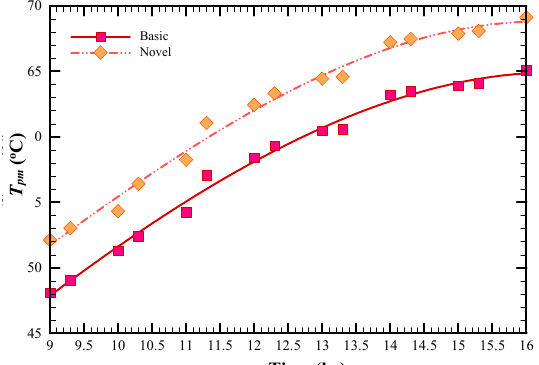
Figure 7. Variation of heat loss for the basic system without a turbulator and novel PTSC equipped with a turbulator and filled with nanofluid at ϕ = 0.019% and Re = 5000 versus different times of day.